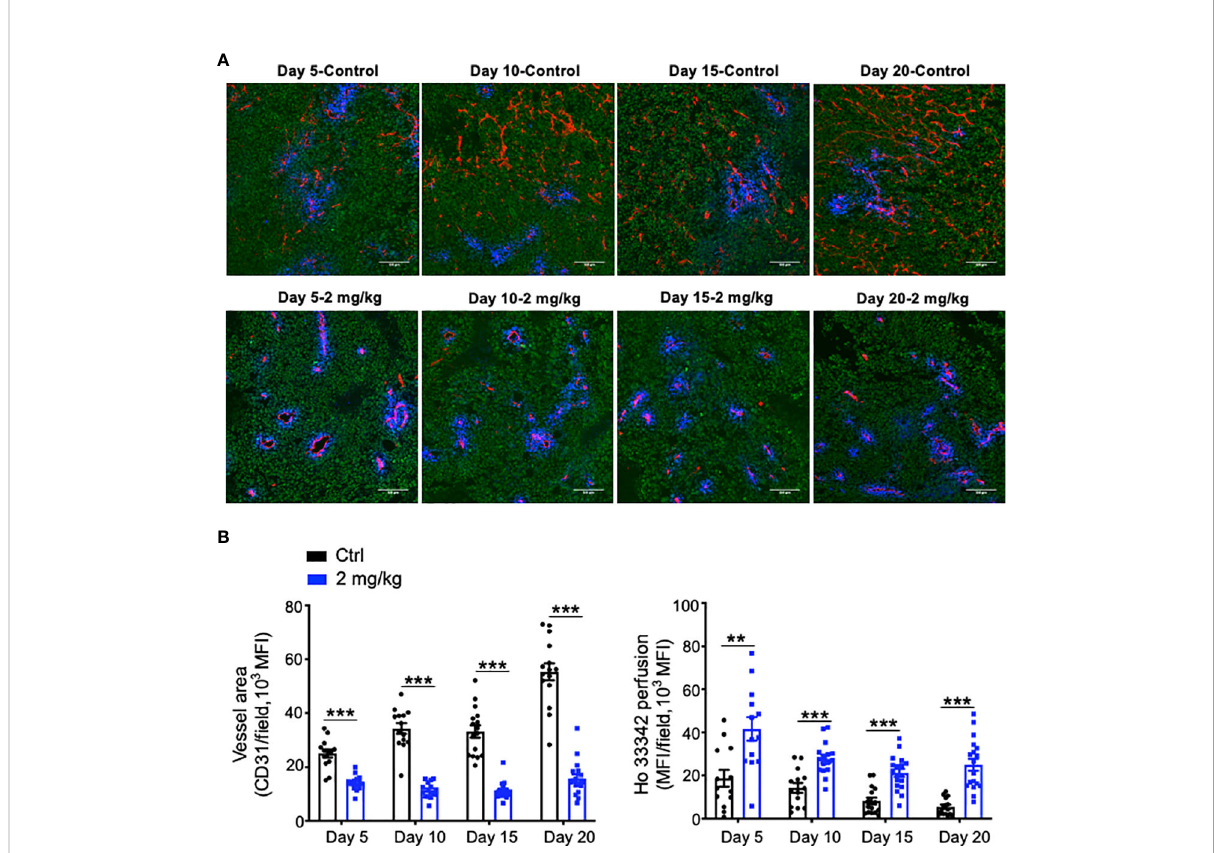
FIGURE 4 Effective low-dose Anlotinib treatments induced long-term tumor vascular normalization. EO771 breast tumor-bearing mice were prepared and Anlotinib treatments (2 mg/kg/daily) were conducted as described in Figure 2. Tumor tissues were harvested on Days 5, 10, 15, and 20 after vehicle control or Anlotinib treatments. (A) Representative images of Ho33342 perfusion (blue) and CD31-staining (red). Scale bar=100 µm. (B) Ho33342 perfused tumor areas and vessel density (CD31). The signi fi cance was determined by unpaired Student ’ s t -test (n=13-19 tumors per group). The data are presented as means±SEM. ** P < 0.01; *** P <